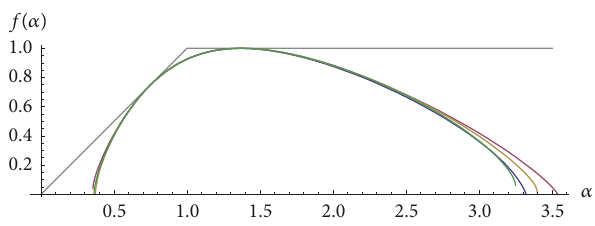
Figure 3: Several coarse multifractal spectra for the random mass distribution of Figure 2, showing very good convergence. The limit function 𝑓(𝛼) is a typical example of multifractal spectrum of self- similar mass